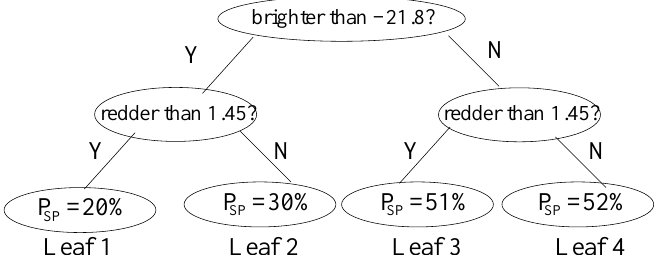
Figure 2. A simple 2-level, 2-parameter decision tree. The value of P SP in each leaf node is the average extent to which training-set galaxies in that node display spiral structure, as measured by the GZ1 vote fraction for P S + P Z . That value is then used as the predicted P SP for galaxies in the non-training set that land in that node. With proper optimization (beyond the scope of this paper), larger trees with more features can produce more accurate predictions of P SP , P EL ,